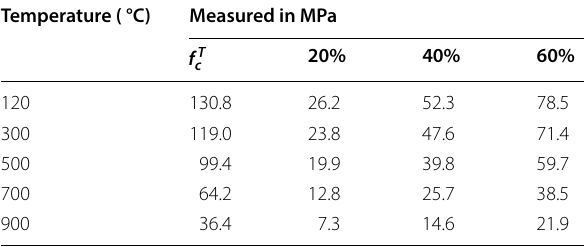
Table 3 Stress levels of HRPC for STC